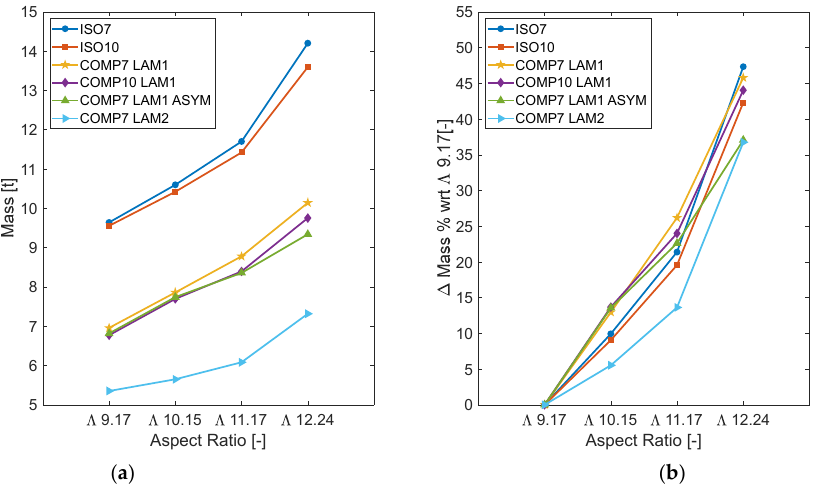
Figure 12. Wingbox mass indicators for different Λ and section layouts: ( a ) wingbox mass vs. Λ ; ( b ) relative wingbox mass variation with respect to same section layout and Λ = 9.17 vs. Λ